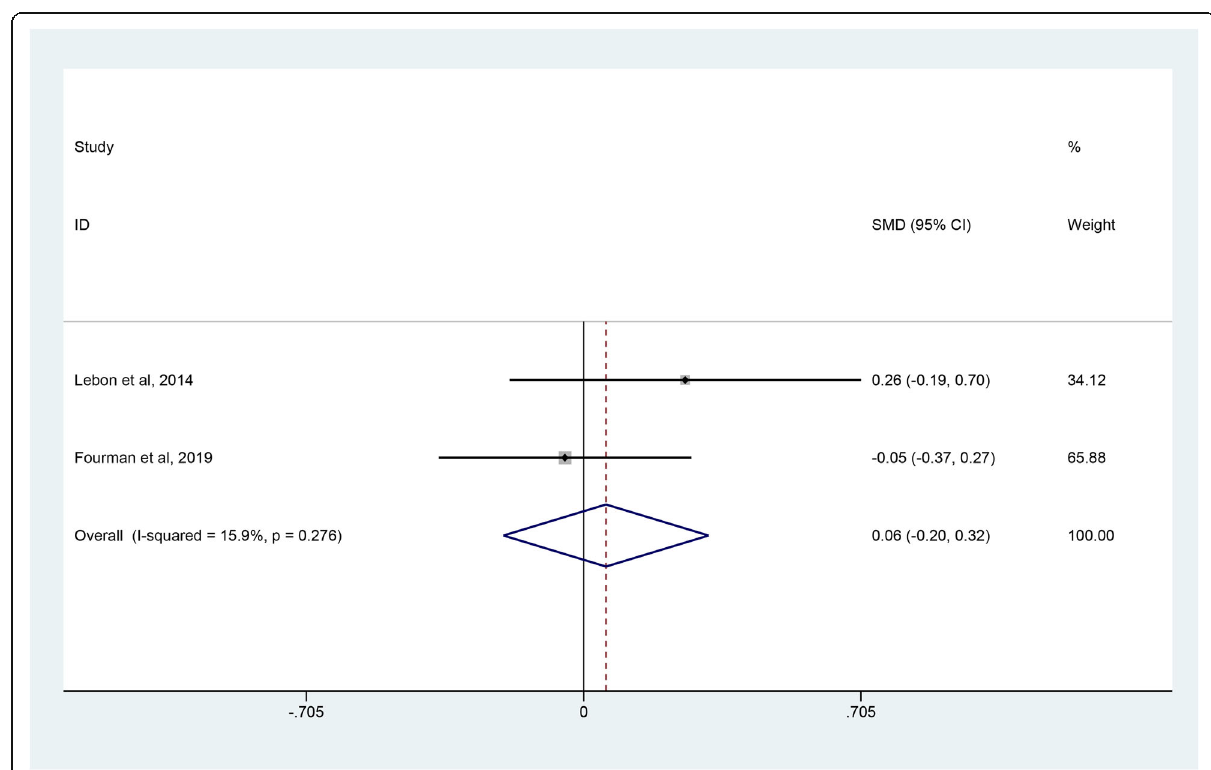
Fig. 6 Forest plot comparing quick-DASH scores after resurfacing hemiarthroplasty (RHA) versus stemmed hemiarthroplasty